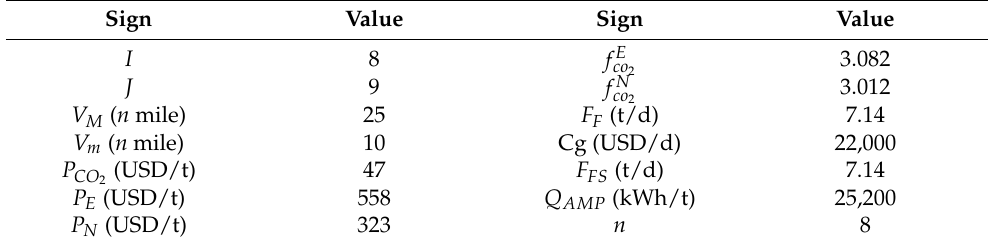
Table 3. Model parameters.